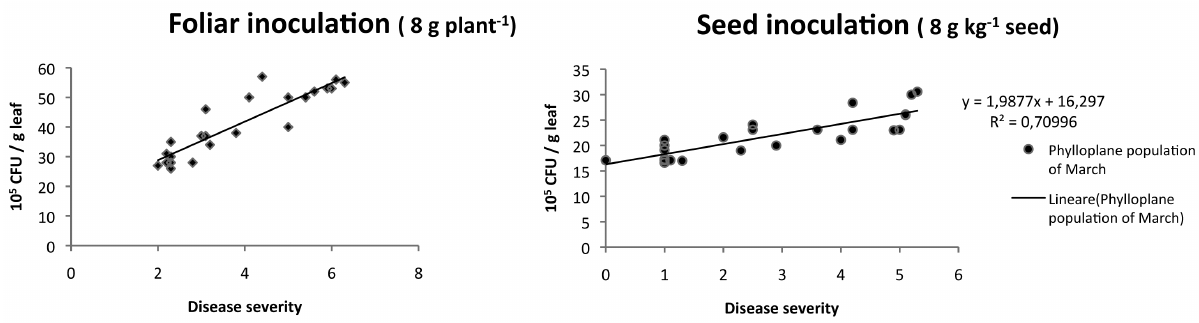
Figure 4. Correlation between disease severity and phylloplane population after foliar and seed inoculation with Botrytis cinerea on chickpea.